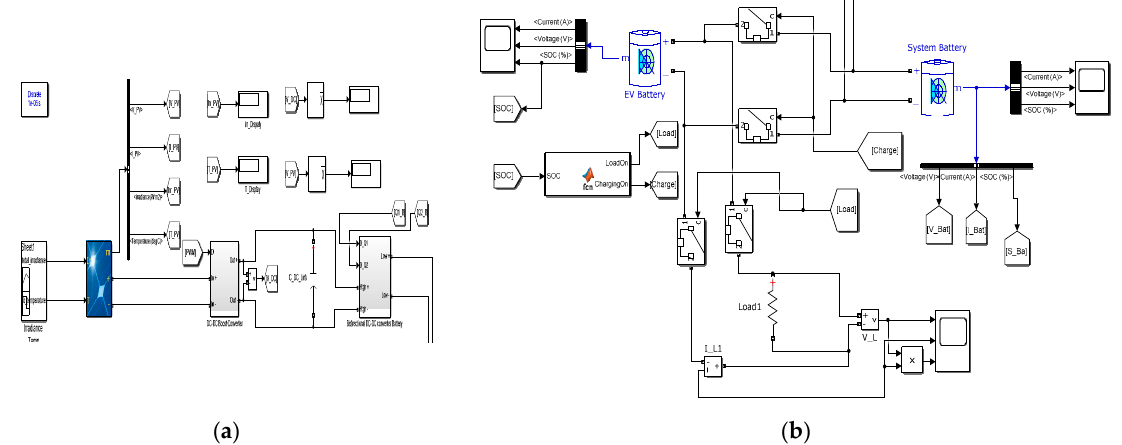
Figure 12. ( a ) Simulation model of plug and play SPRCS (PV system alone); ( b ) simulation model of plug and play SPRCS (battery section).